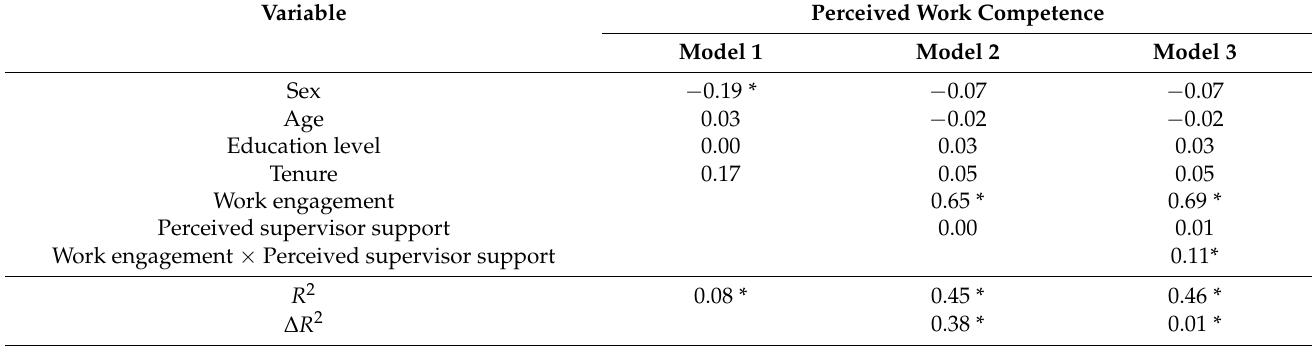
Table 4. Hierarchical regression analysis of variables and their interaction with perceived work